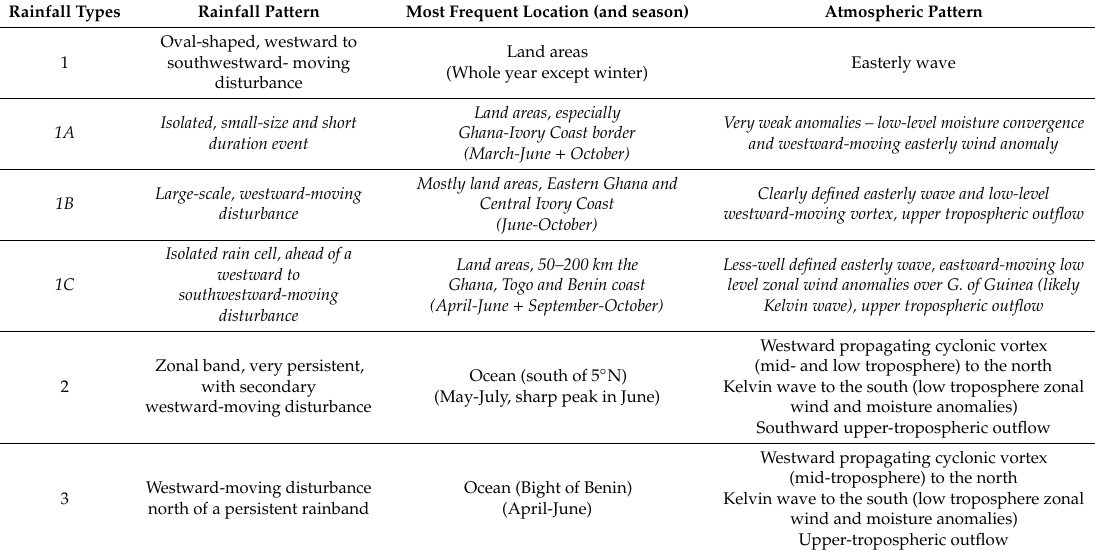
Table 3. Summary of the rain types and associated atmospheric